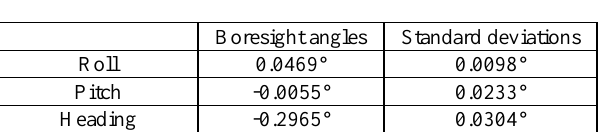
Table 13: Results from Test #2